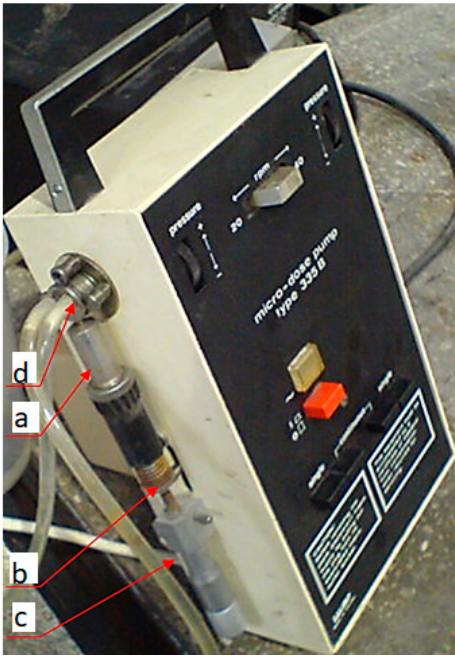
Figure 9. Piston pump supplying the gasification reactor.